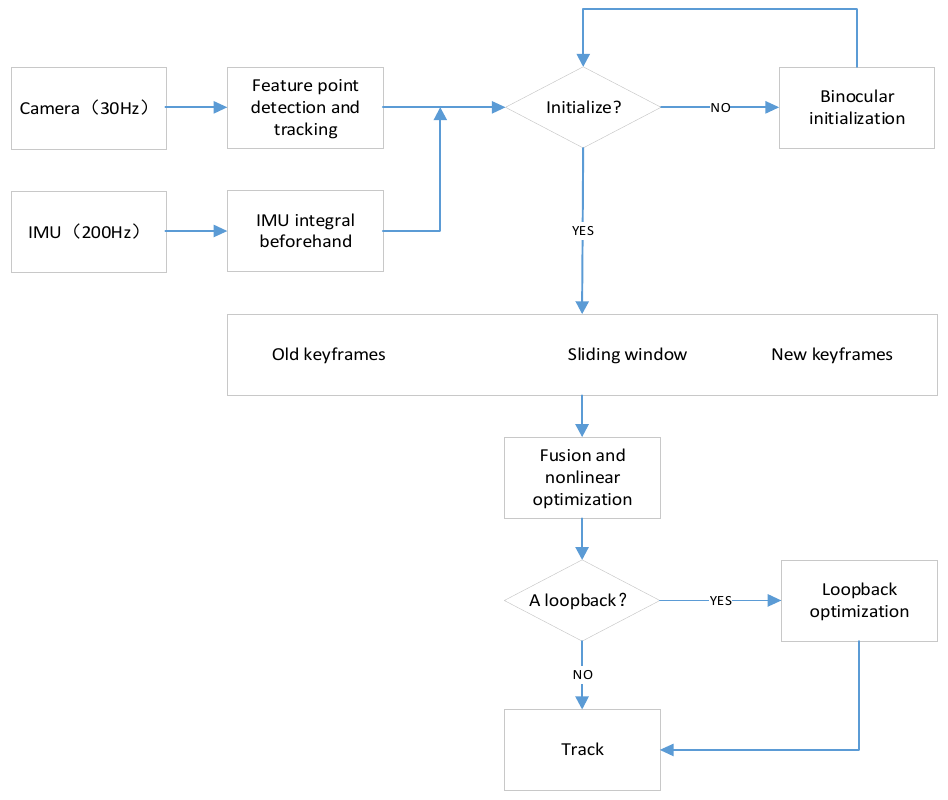
Figure 2. The algorithmic framework used in this paper.